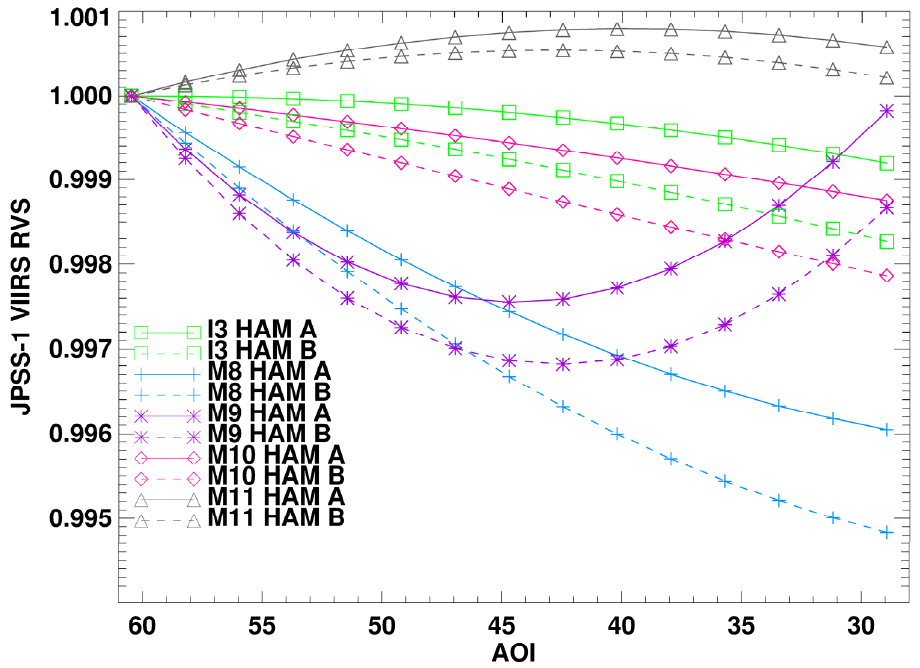
Figure 10. Band-averaged RVS for JPSS-1 VIIRS from the SV AOI to the end of scan AOI for bands I3 and M8-M11.